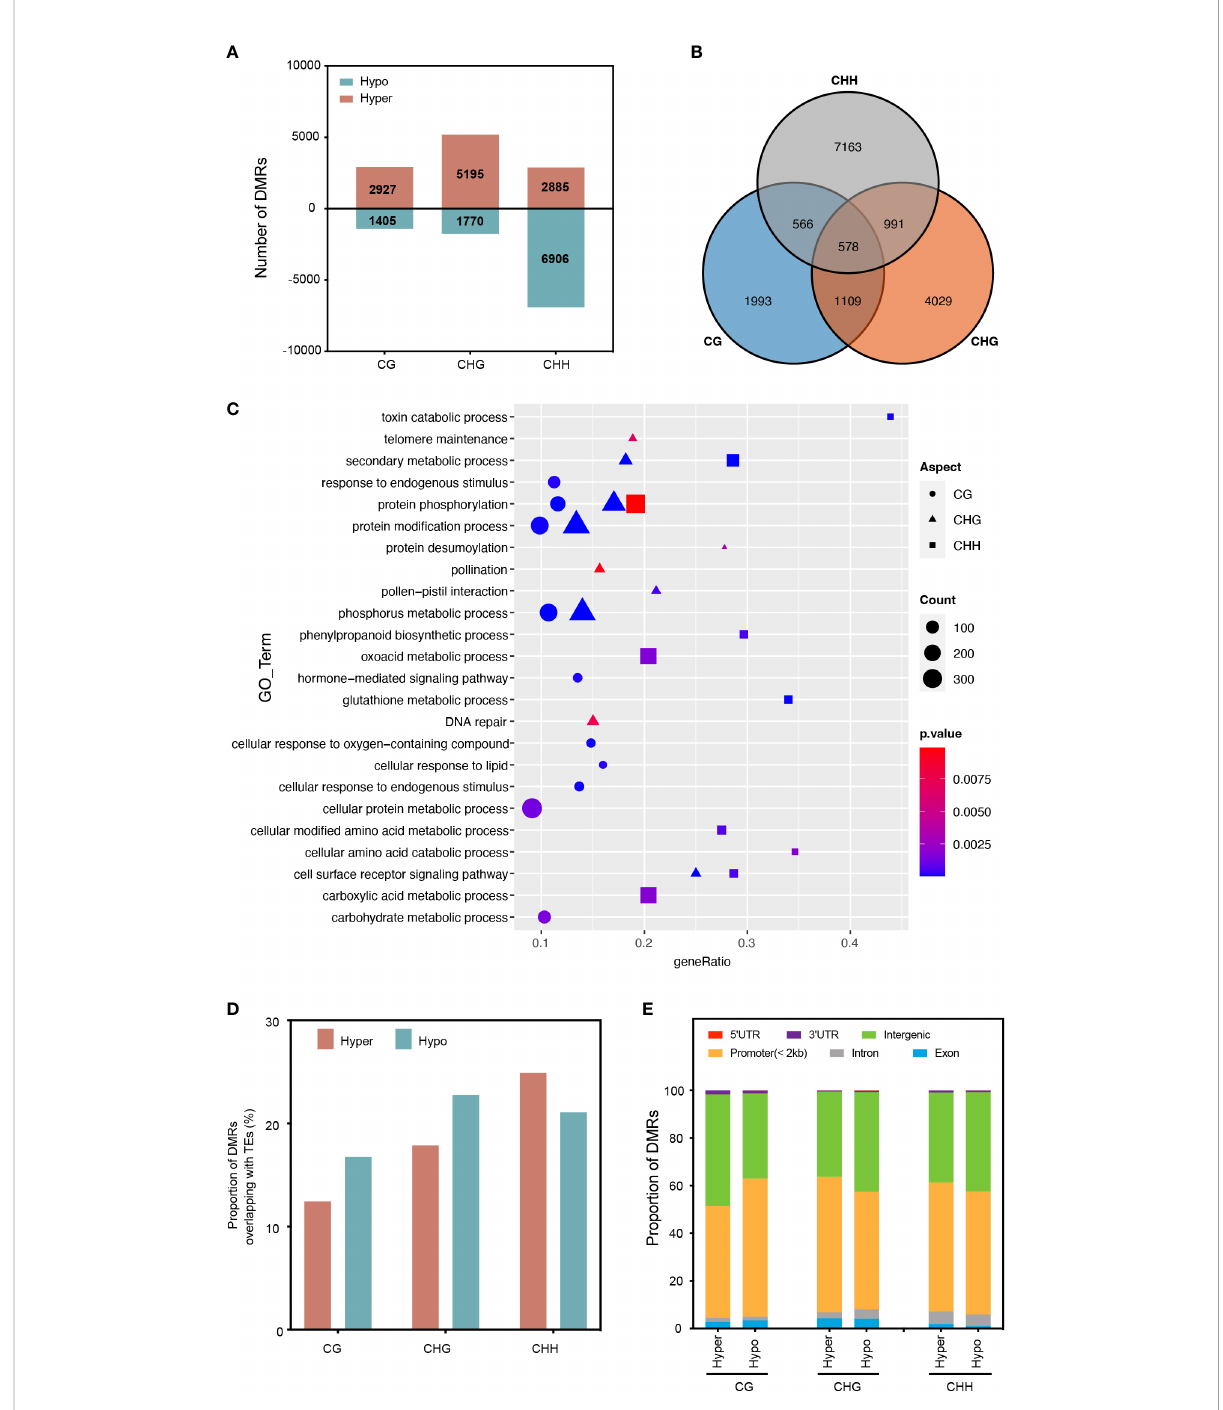
FIGURE 2 Characterization of differentially methylated regions (DMRs) in different cytosine contexts. (A) The number of DMRs near protein-coding genes in rice leaves after RGSV infection (within 1.5 kb). (B) Overlap of DMGs with different methylation contexts. (C) Gene Ontology (GO) analysis of DMGs from different methylation contexts. (D) The proportion of DMRs overlapping with transcriptional elements (TEs). (E) Genomic composition of DMRs surrounding